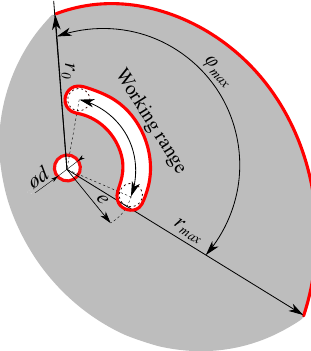
Figure 5. Initial geometric model of the cam. Shapes highlighted in red are fixed and cannot be modified during TOP. The initial geometric model was created using the CAD software SpaceClaim Direct Modeler (Ansys, Canonsburg, PA, USA,